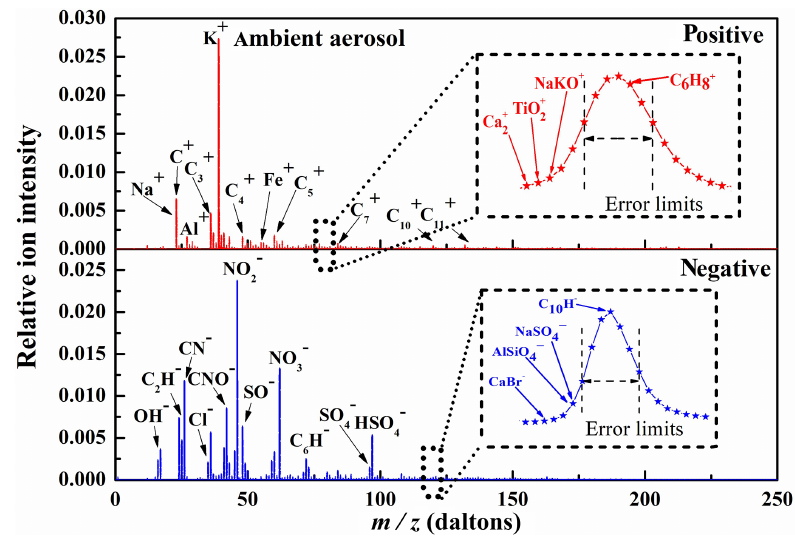
Figure 5. Averaged positive and negative mass spectra of ambient aerosols. Table 3. Peak identification of important chemical species in ambient aerosols. The first column is the measured m/z for each peak. The second and third columns show the theoretical m/z bin value and theoretical m/z value of most possible species for each peak. Measurement Possible species Possible species Measurement Possible species Possible species m/z (positive) (theoretical m/z (theoretical m/z m/z (negative) (theoretical m/z (theoretical m/z bin value) value) bin value)